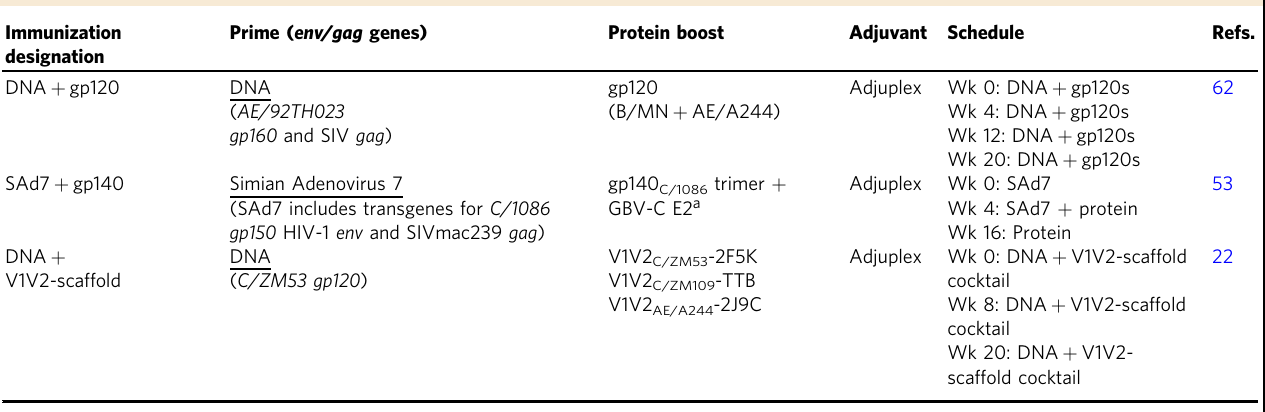
Table 1 HIV-1 vaccine regimens studied in M. mulatta